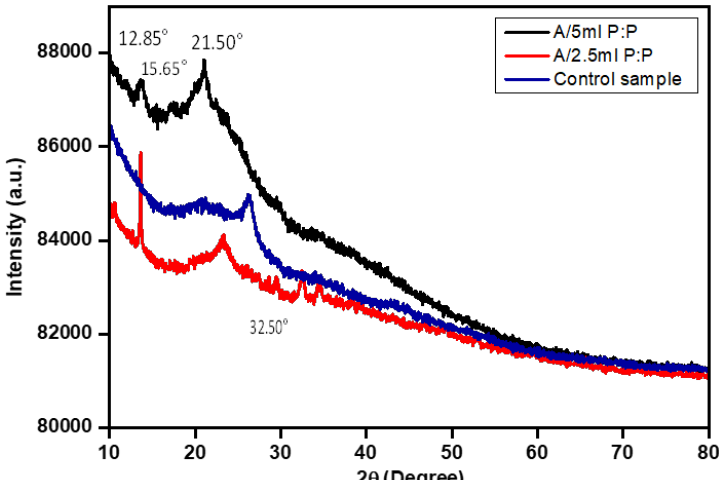
Figure 4. Relative intensity XRD plot of the alginate and A/P:P hydrogel.